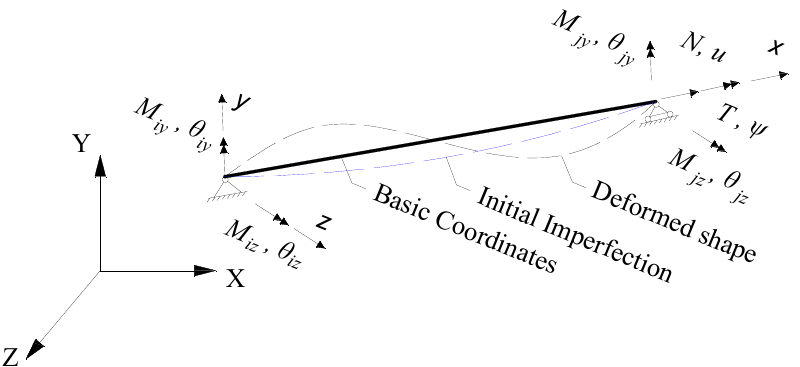
Figure 2. Force vs. displacement relations in basis system.